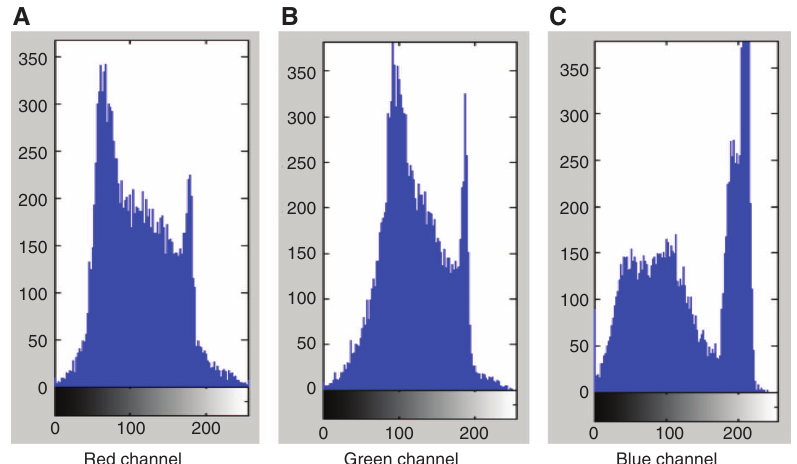
Figure 5: Histogram Distribution of the Original Image.